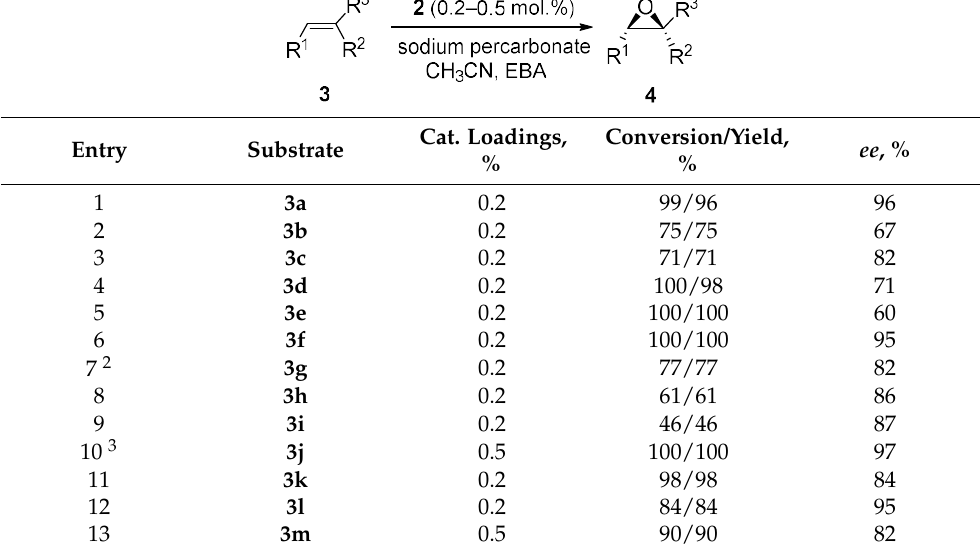
Table 3. Asymmetric epoxidation of olefins with sodium percarbonate in the presence of 2 1 .